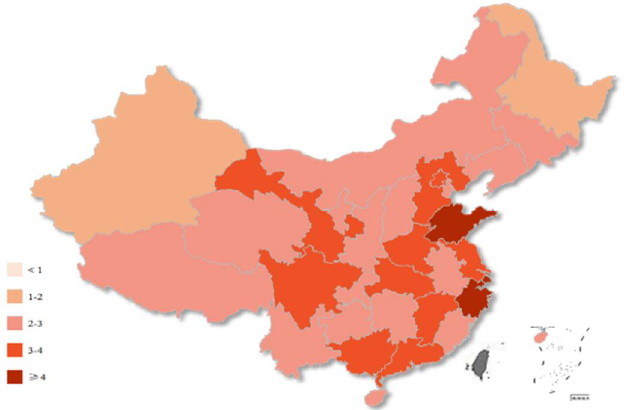
Figure 1. The total number of primary health institutions and the number of beds and personnel per 10 thousand residents in primary health institutions in China between 2013 and 2020.